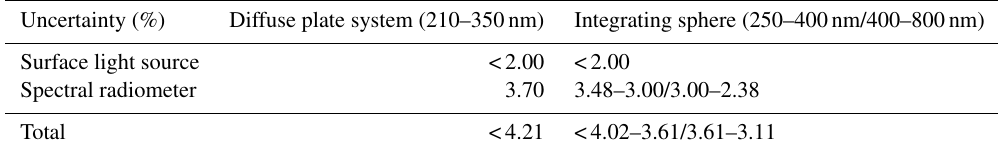
Table 7. Radiometric accuracy of the calibration